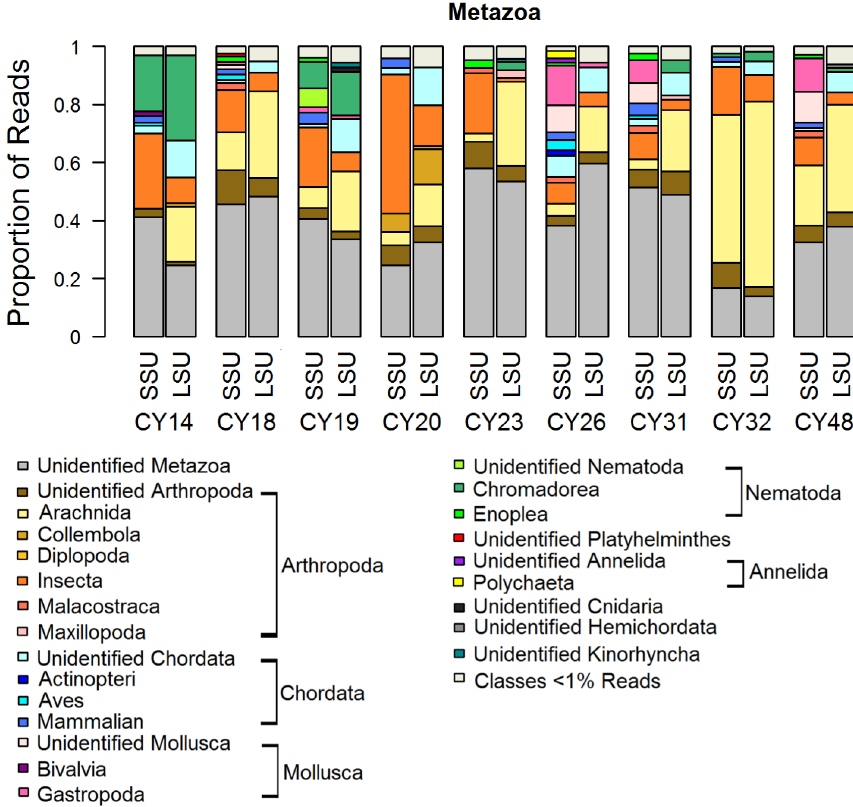
Figure 4. Taxonomic composition of Metazoa. Taxonomic classification and proportion of SSU and LSU reads of Metazoa at the class